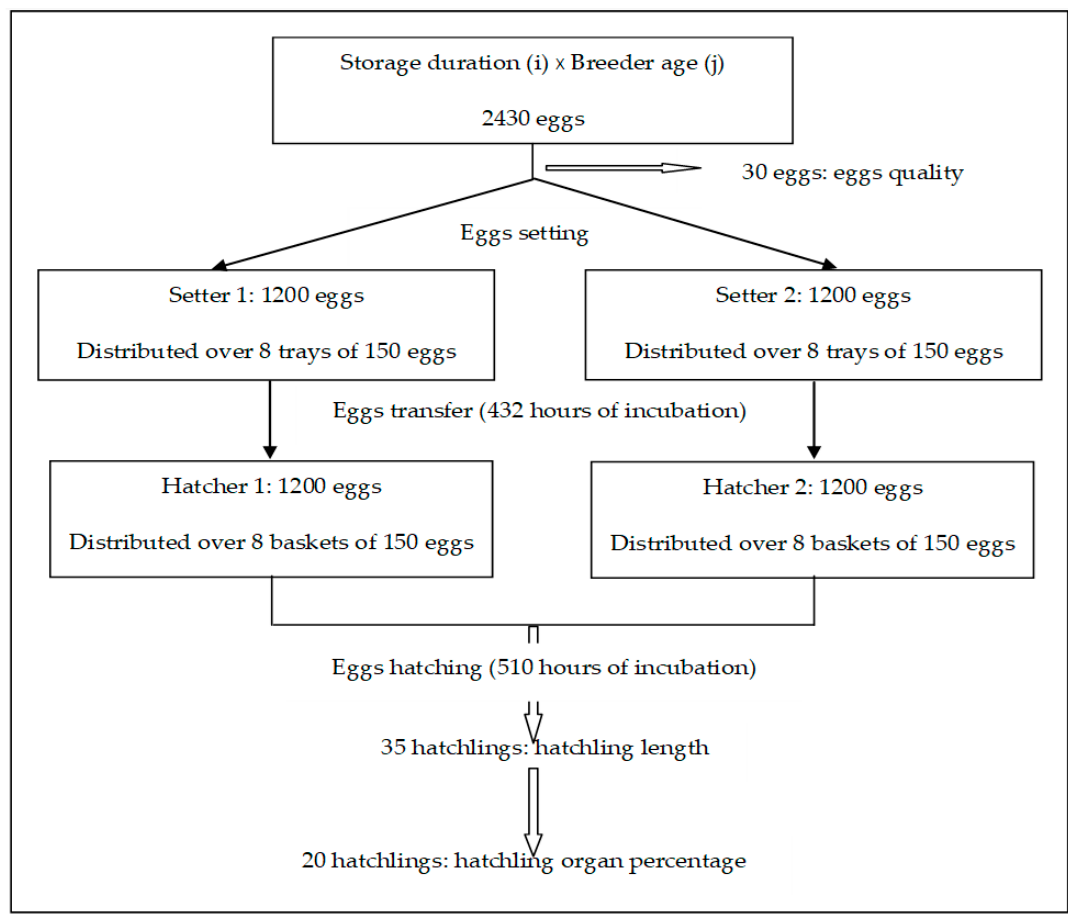
Figure 1. Random repetition scheme from one combination (treatment). Storage duration (i = 2, 5, 12 or 19 days), breeder age (j = 31, 42 or 66 weeks). Hatchling length and hatchling organ percentages were considered only with storage durations of 5 and 19 days.